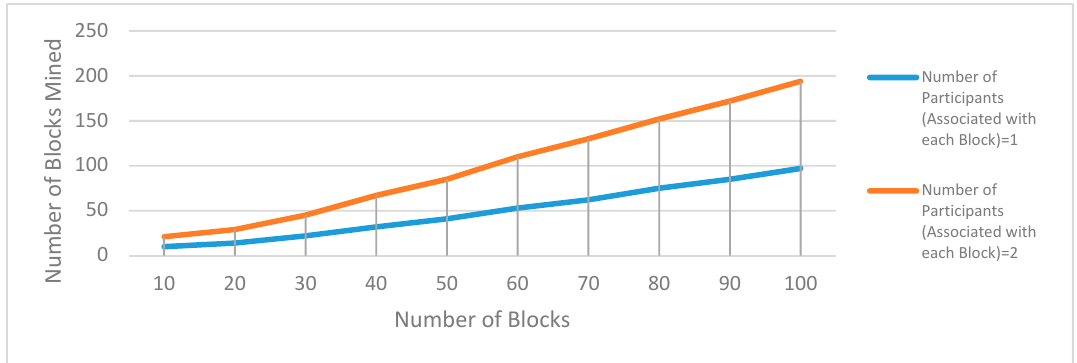
Figure 30. Analysis of the number of blocks mined as the number of participants associated with those blocks increases with time.